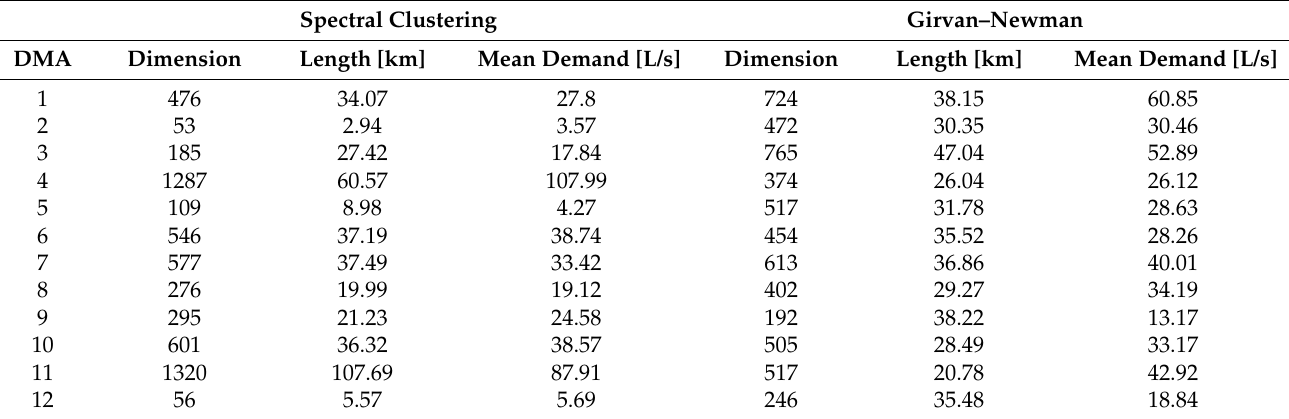
Figure 4. ( a ) Udine WDN clustering: spectral clustering algorithm—12 DMAs; ( b ) Udine WDN clustering: Girvan–Newman algorithm—12 DMAs. Table 3. Udine: DMAs features for spectral clustering and the Girvan–Newman